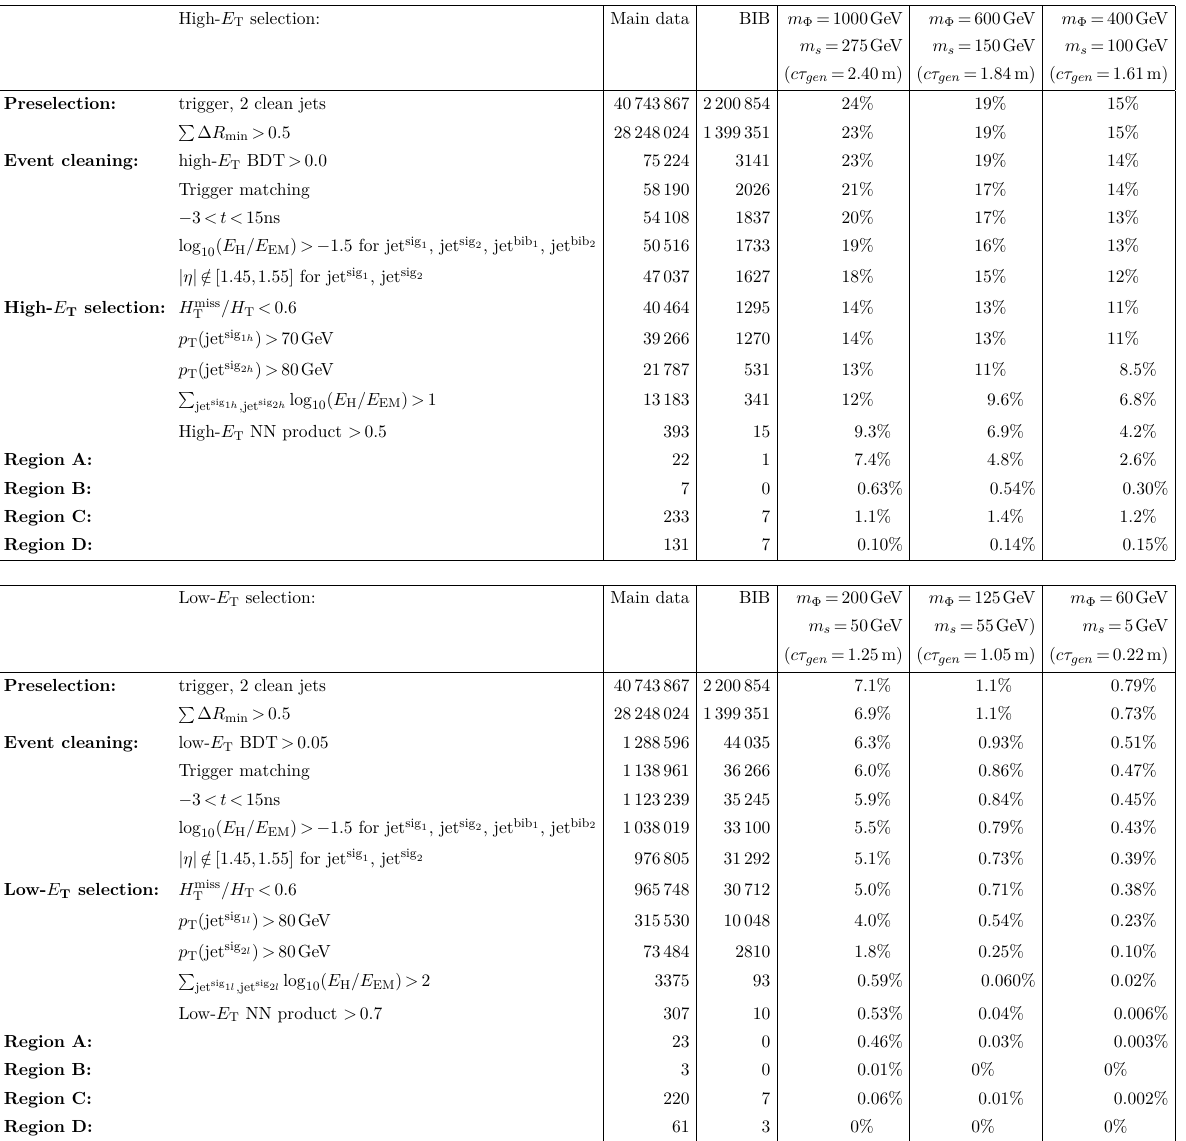
Table 3. Sequential impact of each requirement on the number of events passing the selection for the high- E T (top table) and low- E T (bottom table) selections. The signal columns represent the cumulative fraction of events passing the selection than the number of